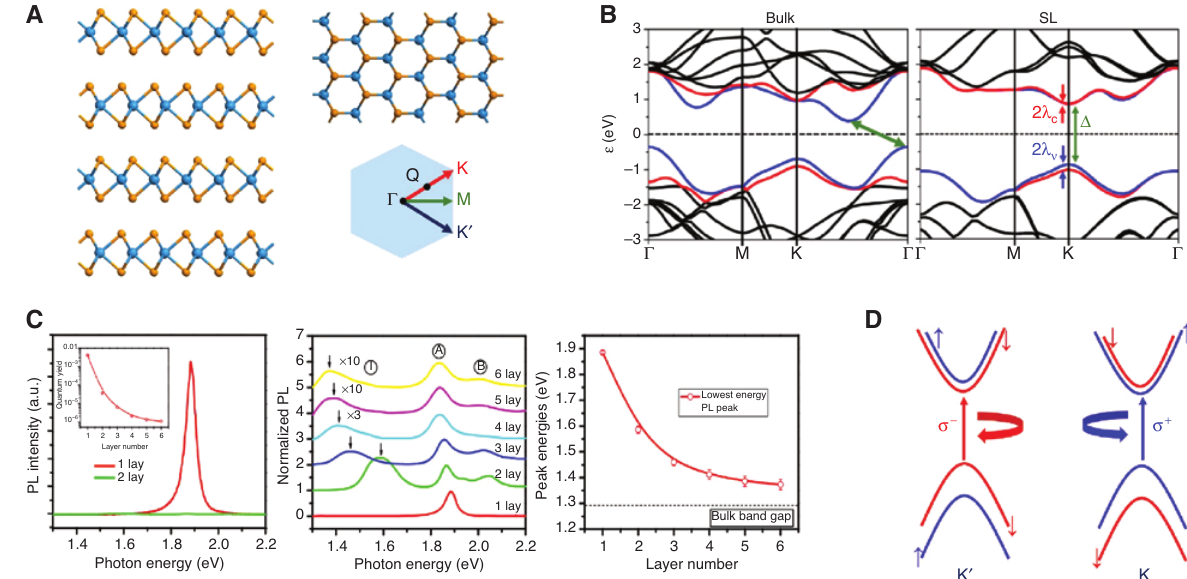
Figure 1: Electronic and optical properties of SL TMDCs. (A) Structure of MX , blue spheres represents transition metal M atoms, while brown spheres represent chalcogen X atoms. (B) The 2 energy band structure of bulk (left) and SL (right) pristine MoS , which shows that bulk MoS is an indirect while SL MoS is a direct band 2 2 2 gap semiconductor. Basic topology of the band structure for all TMDCs is essentially the same, details are, however, different which are summarized in Table. 1. Blue curves show the valance band (VB) and conduction band (CB), while red curves show VB-1 and CB + 1. (C) Photoluminescence spectra, which show an order of magnitude difference in absorption between SL and bilayer MoS [3]. Also it can 2 be seen that band gap shifts as a function of thickness. (D) A schematic illustration of circular dichroism. Electronic bands around K and K ′ points (for instance for MoX ). Spin and valley degrees of freedom are locked together, which results in optical valley-dependent 2 selection rules.